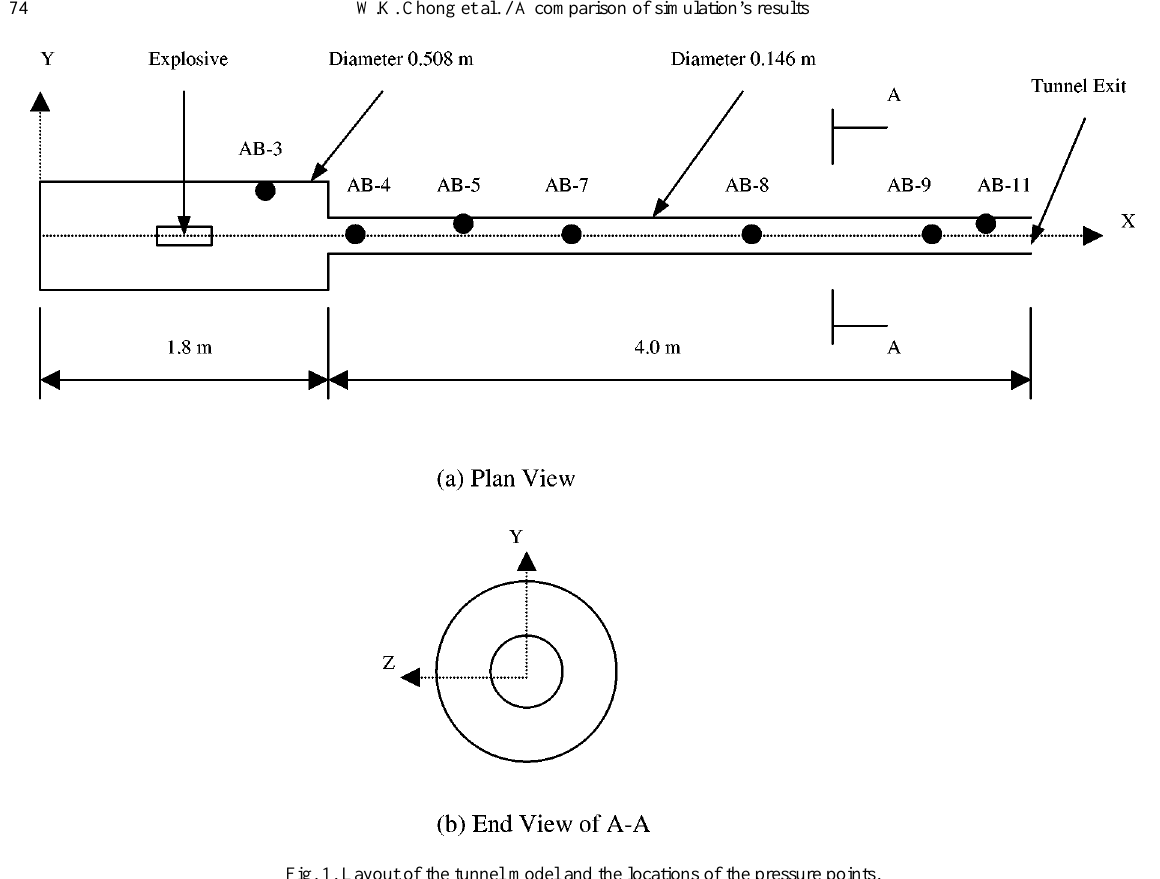
Fig. 1. Layout of the tunnel model and the locations of the pressure